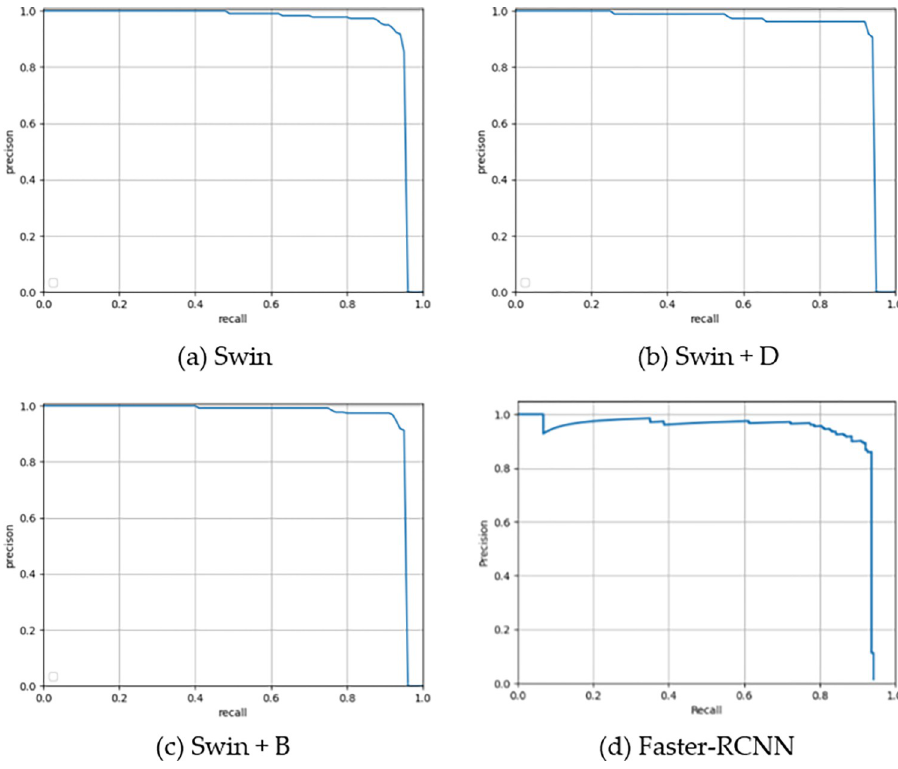
Fig 12. P-R curve for each part of the ablation study on the SDTs dataset.